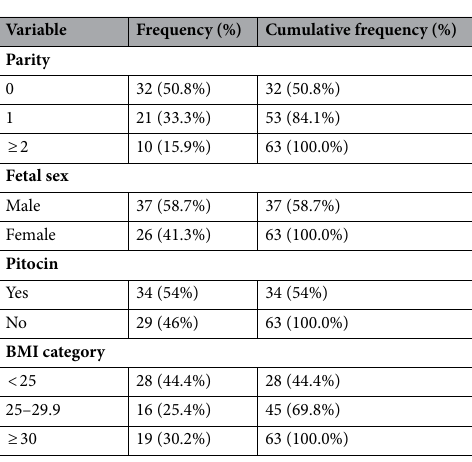
Table 2. Patient characteristics, categorical variables.